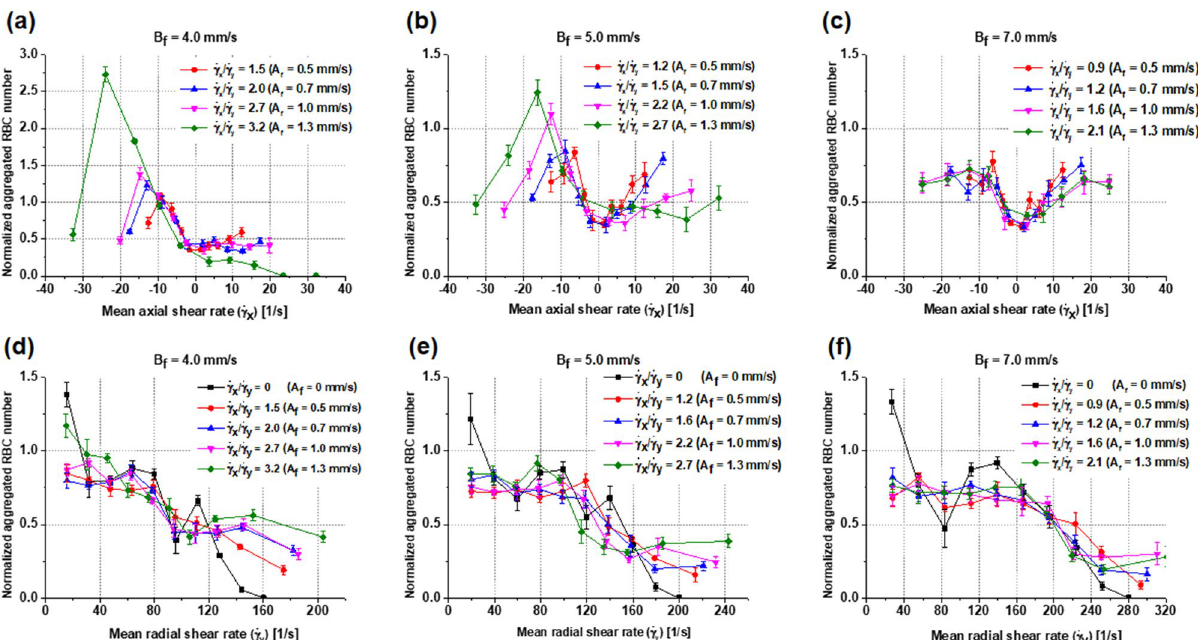
Figure 4. Normalized aggregated RBC numbers were computed as a function of the axial and radial shear rates via the ratio of axial shear rate ( ˙ γ x ) over radial shear rate ( ˙ γ y ) at the tube center, with changing velocity amplitude from 0 to 1.3 mm/s and mean flow velocity of 4, 5, and 7 mm/s at a normalized time (t/T = 0.9). Symbols and error bars indicate means and standard deviations over five periods, respectively. ( a – c ) and ( d – f ) are the normalized number of aggregated RBCs as a function of the mean axial shear rate ( ˙ γ x ) and mean radial shear rate ( ˙ γ y ) at 10 ROIs of the same area, respectively, for different amplitudes and means of flow